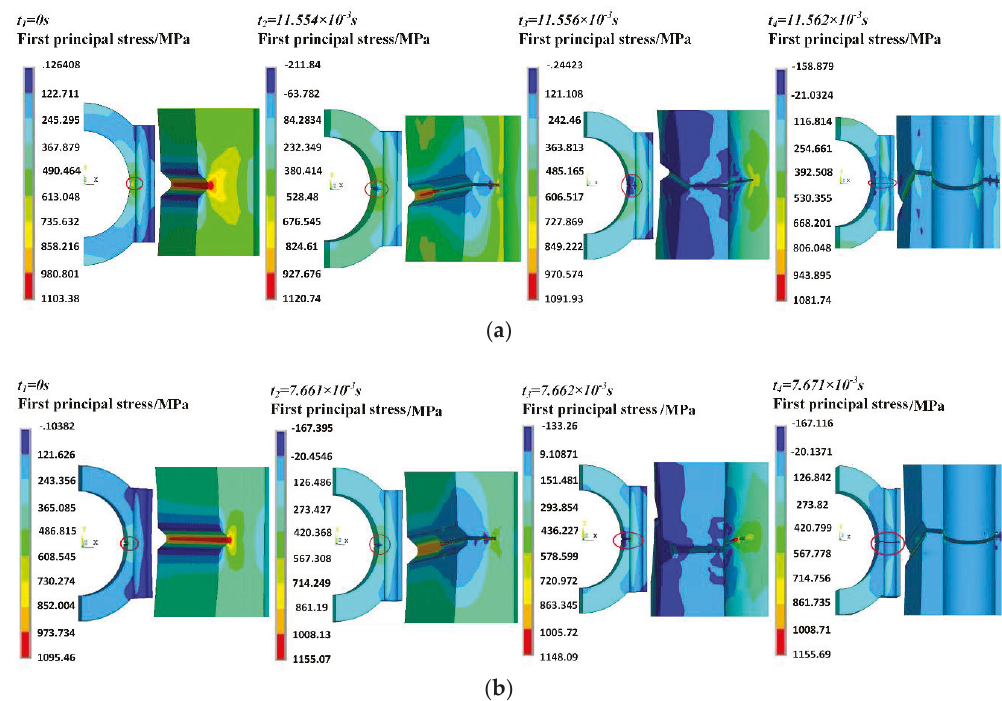
Figure 6. The first principal stress distribution of the connecting rods: ( a ) C70S6; ( b ) 36MnVS4.